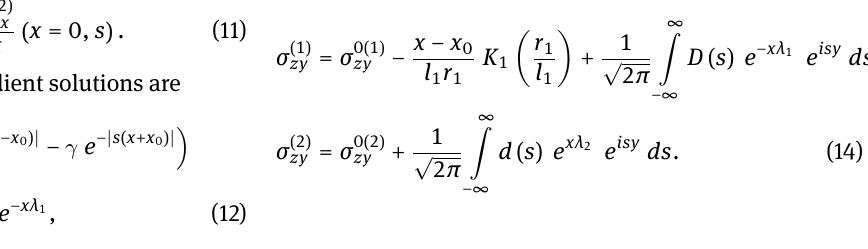
In the same manner, the gradient solution of the zy - component of the stress field can be